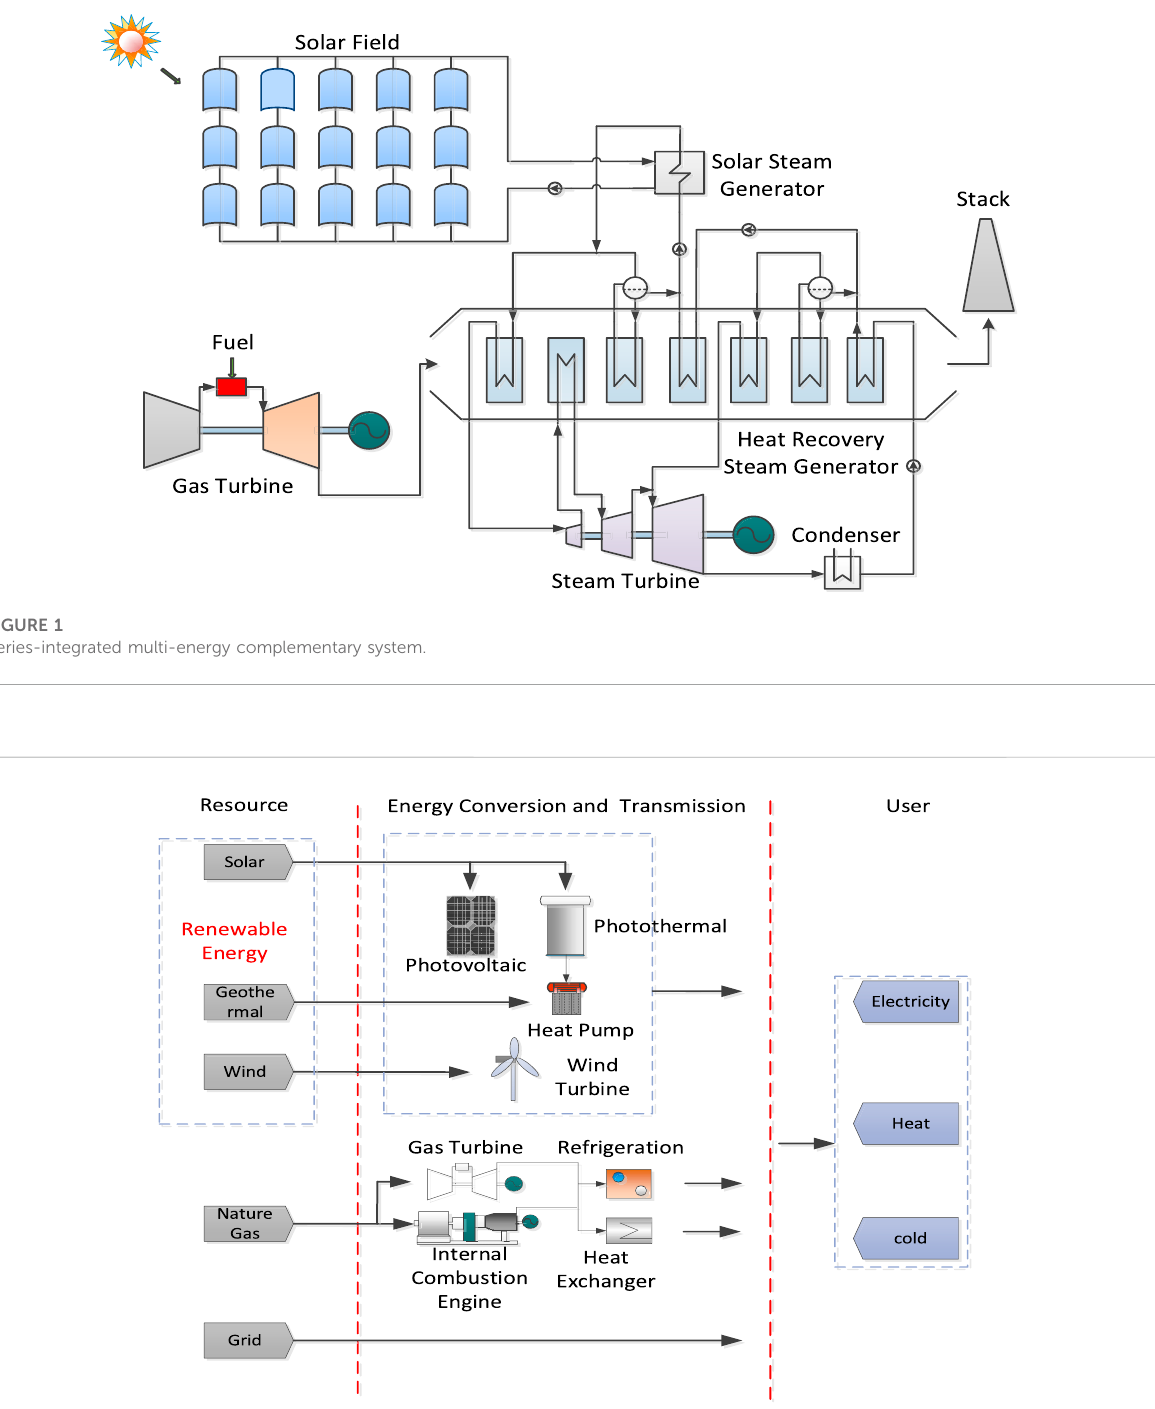
FIGURE 2 Parallel-integrated multi-energy complementary